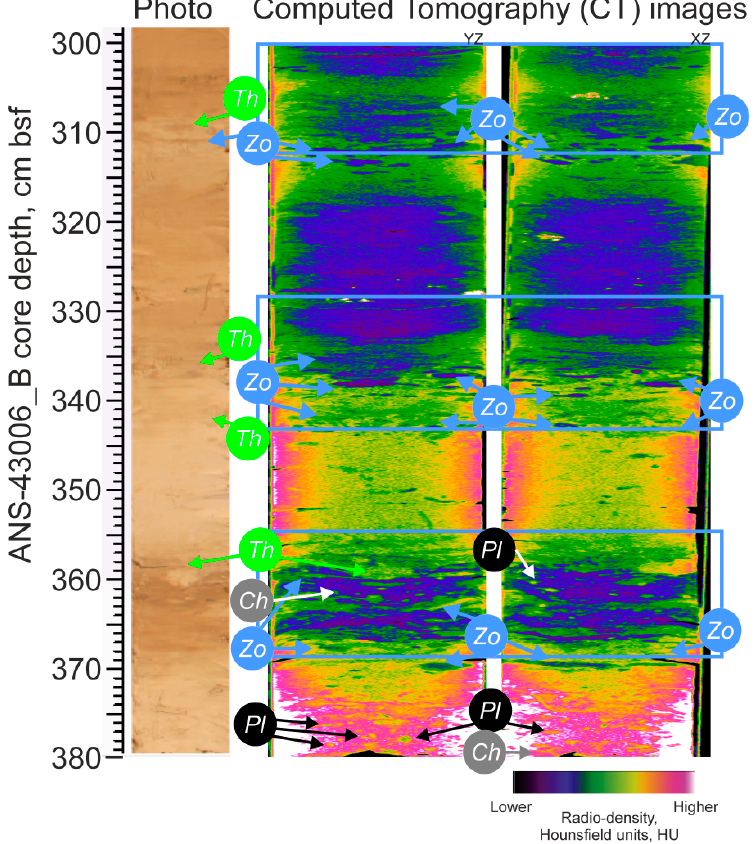
Figure 6. The lower part of the ANS-43006_B sediment core illustrates an example of the different ichnotaxa on the photo and CT images: Th, Thalassinoides; Pl, Planolites; Zo, Zoophycos; Ch, Chondrites.